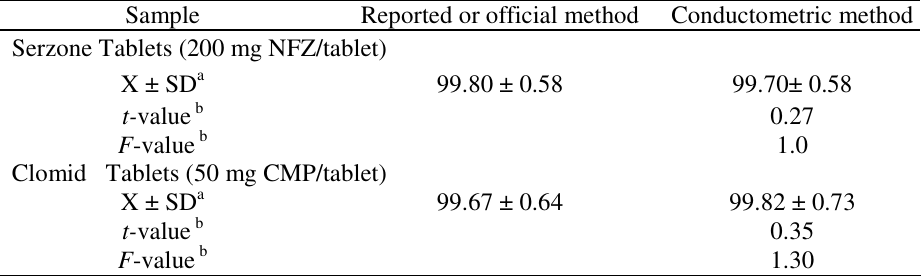
Table 7. Application of the proposed conductometric method to the determination of the studied drugs in dosage forms.